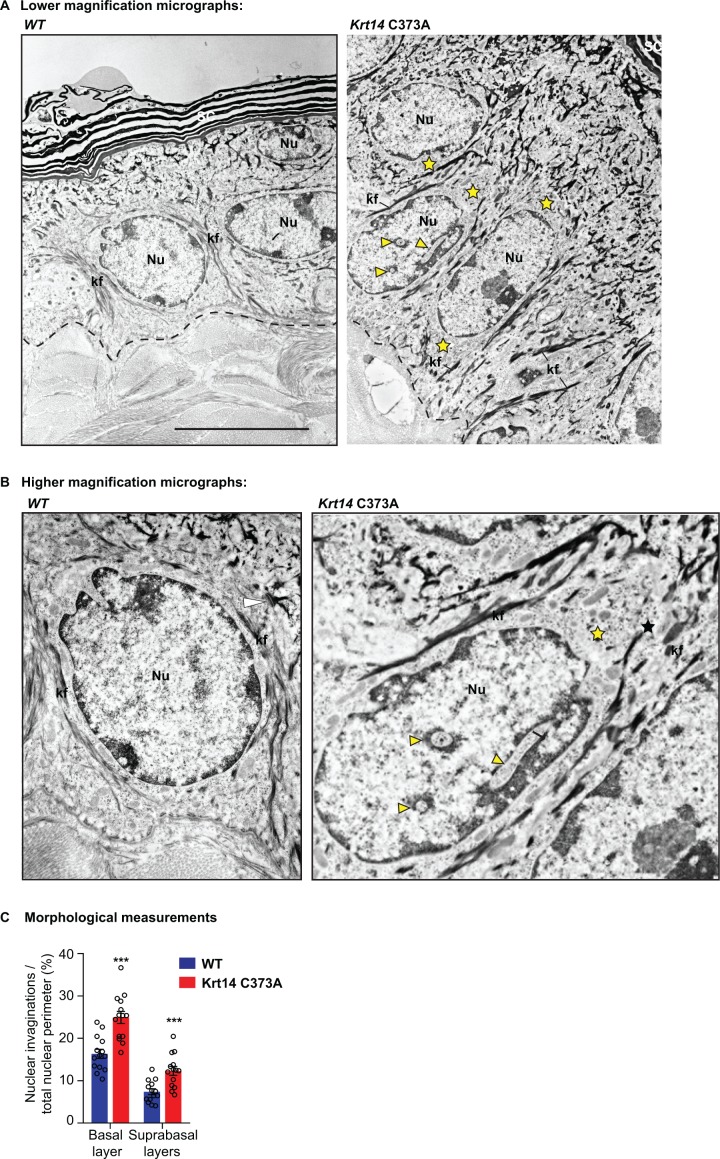
Ultrastructural changes and abnormal nuclei in Krt14 C373A keratinocytes.(A) Transmission electron micrograph of ear skin epidermis from WT and Krt14C373A mice. (B) High magnification images of representative cells in frame a. Dotted lines mark the dermo-epidermal interface. Asterisks depict areas showing abnormal gaps between keratin filaments (kf) and the nucleus (Nu) in mutant Krt14 C373A keratinocytes. Arrowheads depict cytoplasmic invaginations into the nucleus in Krt14 C373A keratinocytes. Scale bar, 5 µm. (C) Quantification of frequency of nuclear invaginations (n = 14 nuclei from two biological replicates for each genotype). Data represent mean ± SEM. Student’s t test: ***p<0.005.